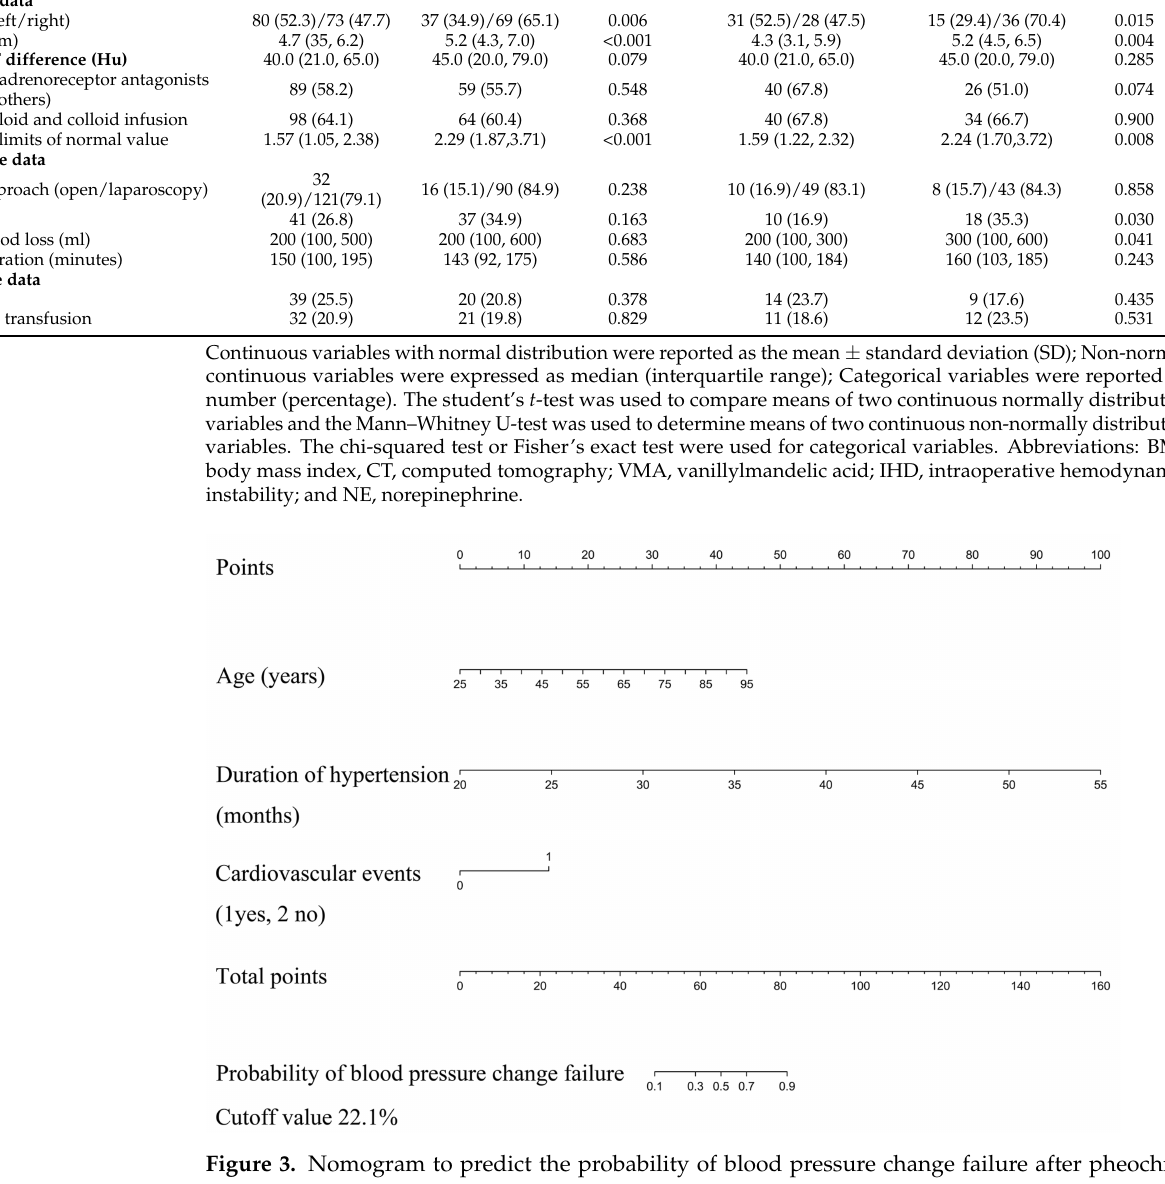
Figure 3. Nomogram to predict the probability of blood pressure change failure after pheochro- mocytoma surgery. Each clinicopathologic factor corresponds to a specific point by drawing a line straight upward to the point axis. After summing the points located on the total points axis, the sum represents the probability of blood pressure change failure in patients with pheochromocytoma after